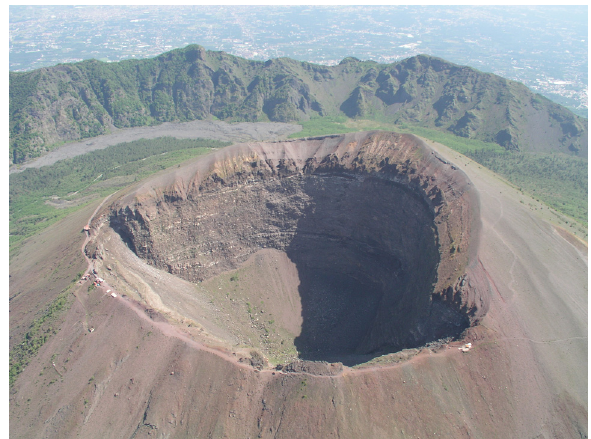
Figure 2. Oblique view of the Vesuvius crater (Gran Cono) formed during the eruption of 1944. The steep walls of the crater suggest that it was formed by a collapse inside the evacuated portion of the shallow magma reservoir (<2 km) feeding the permanent activity between 1913 and 1944. On the background, the border of the Somma caldera, formed as a result of the collapses following the main plinian eruptions of the last 17,000 years. (Photo